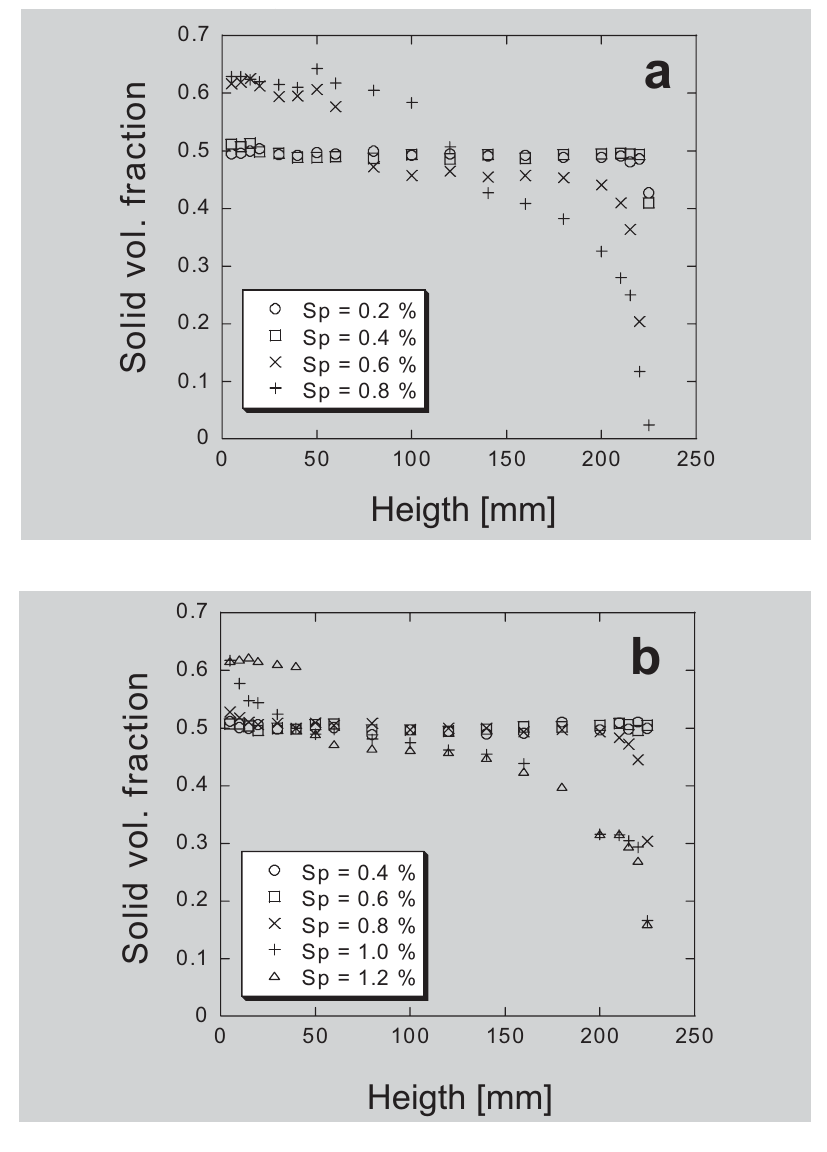
Figure 4: Volume fraction profile of cement grout versus superplasticizer concentration without silica fume (a) (above) and with silica fume (b)